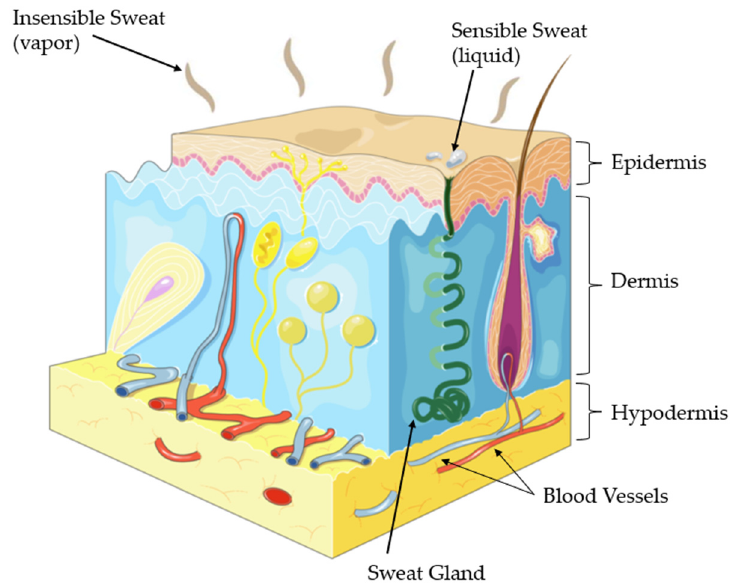
Figure 3. Human skin structure and two types of sweat loss in the skin surface: sensible sweat and insensible sweat [50].